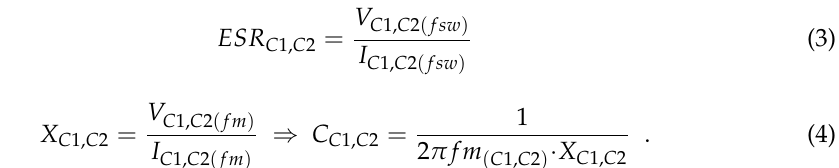
Figure 7. Fault-tolerant LED lighting system integrating the proposed FDA.